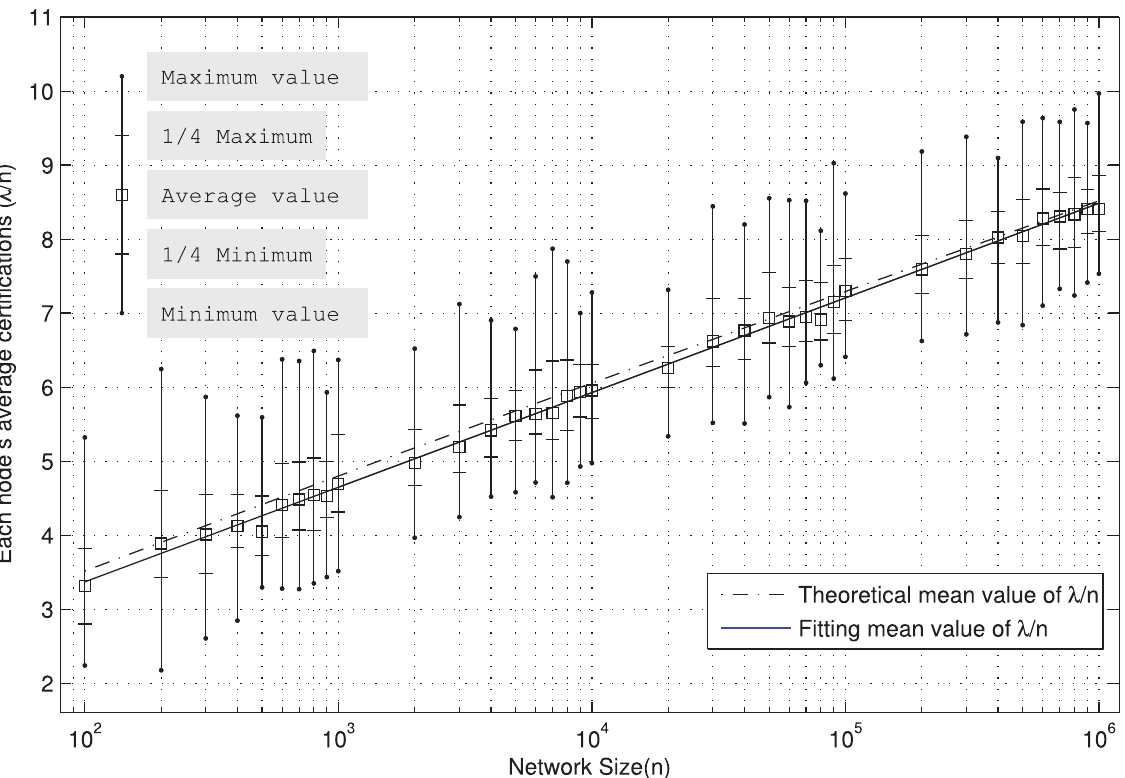
Figure 3. In different network size, the average number of certifications l network size, and the vertical coordinate is the average number of certifications saved on every node ( l = n ). For each network size n , the mean value, 1 = 4 maximum value, and 1 = 4 minimum value of 100 rounds tests are calculated.